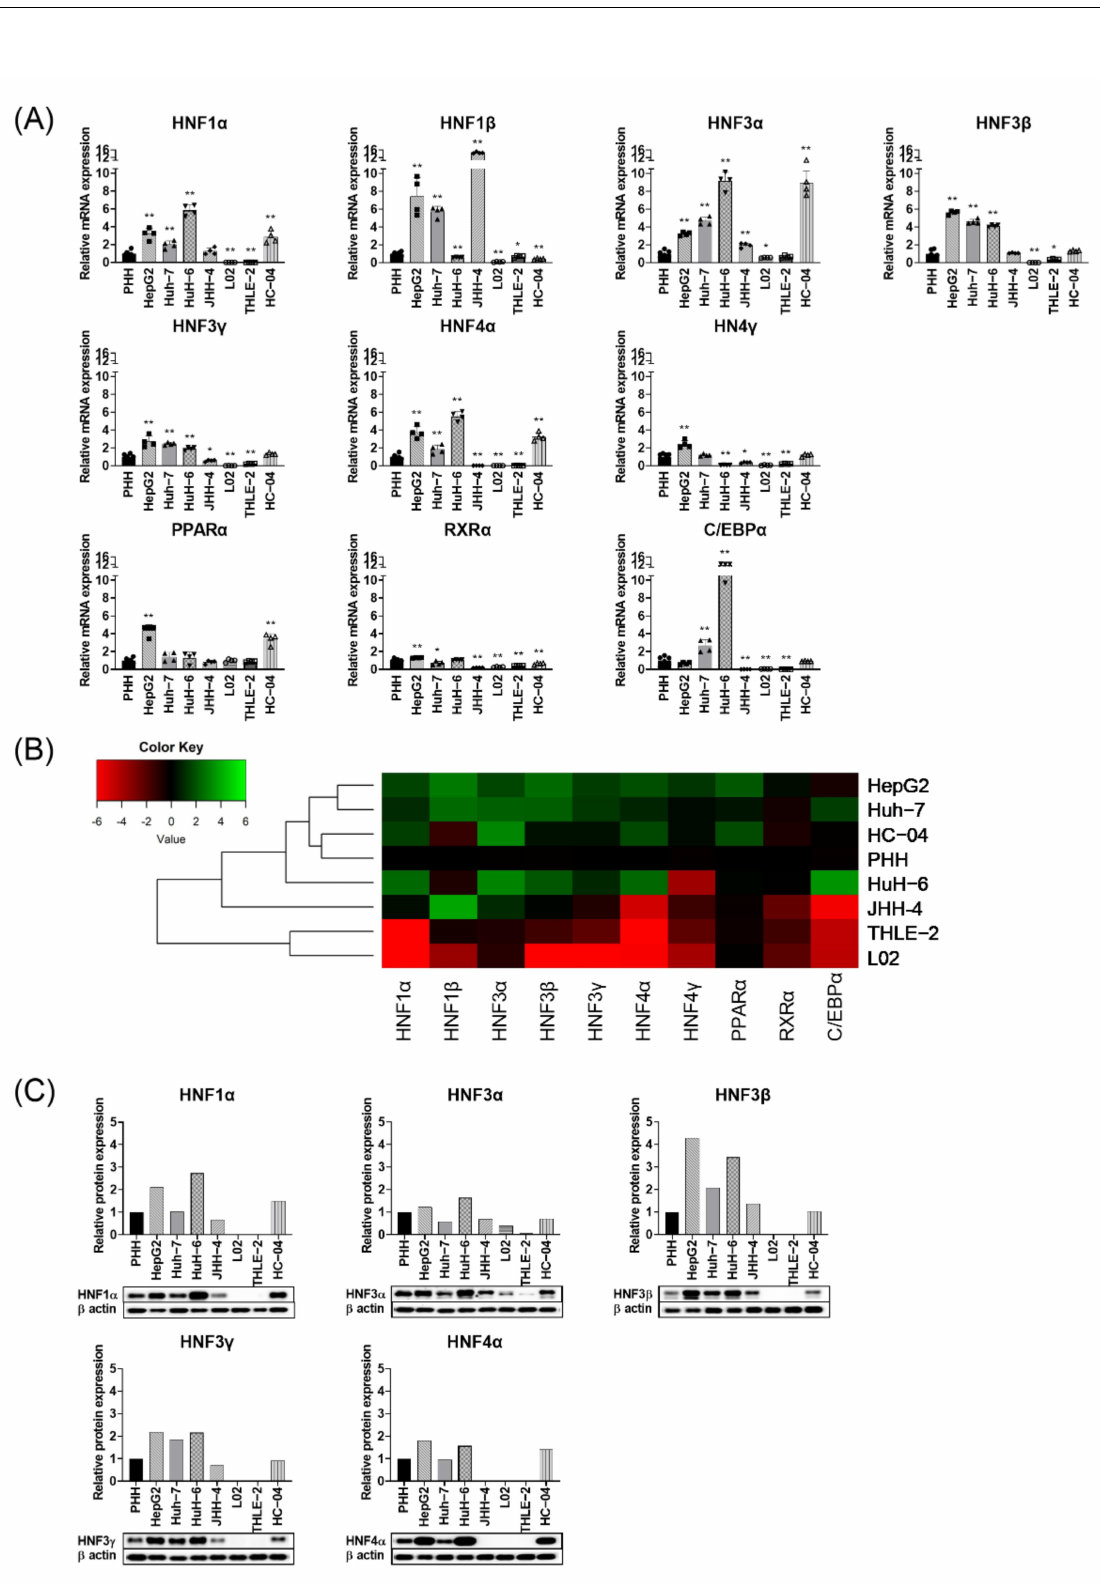
Figure 1. Liver enriched TFs expression level among liver-derived cell lines. ( A ) Relative mRNA expression of liver enriched TFs to primary human hepatocytes (PHH). Each data bar represents the mean + SD from two independent experiments, each done in duplicates. The values for PHH are from 3 different donors. * p < 0.05, ** p < 0.01, t -test done by comparing each of the cell lines to PHH. ( B ) Hierarchical clustering of mRNA expression of liver enriched TFs among hepatoma cell lines relative to PHH. ( C ) Relative protein expression of liver enriched TFs. β -actin was used as an internal